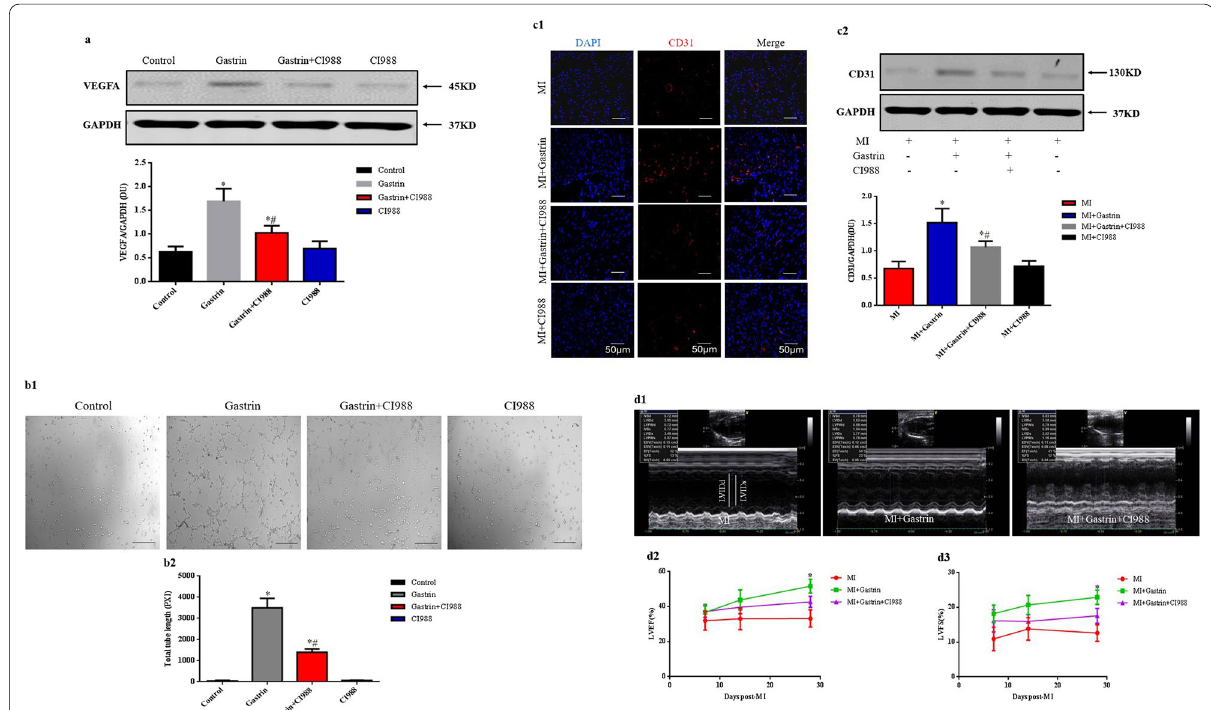
Fig. 6 CCK 2 R role in the protective effects of gastrin against myocardial infarction. Endothelial cells were treated with gastrin (100 nM) with or without the CCK 2 R inhibitor, CI988 (100 nM). a Western blot was used to detect the protein levels of vascular endothelial growth factor (VEGFA). Results are expressed as the ratio of VEGFA to GAPDH. n 4. * P < 0.05, vs. Control; # P < 0.05, vs. gastrin-treated group. b Representative images and = quantification of endothelial cell tube formation assay in vitro. Scale bar 50 µm. n 4. * P < 0.05, vs. Control; # P < 0.05, vs gastrin-treated group. = = Myocardial infarction mice were infused with gastrin or/and CI988. c1 Immunofluorescence staining with anti-cluster of differentiation 31 (CD31) antibody showed the microvessel densities in the infarcted border zone 14 days after MI. DAPI is blue, and CD31 is red. Scale bar 50 µm. c2 = Western blot was used to detect the protein levels of CD31 in the peri-infarct area of the heart 14 days after MI. Results are expressed as the ratio of CD31 to GAPDH. n 8. * P < 0.05, vs. MI group; # P < 0.05, vs gastrin-treated MI mice. d1 Representative M-mode images of hearts with MI 28 days = after gastrin or/and CI988 infusion. d2–3 Left ventricle ejection fraction (EF), fractional shortening (FS) 7, 14, and 28 days after MI. n 8. * P < 0.05, vs. =